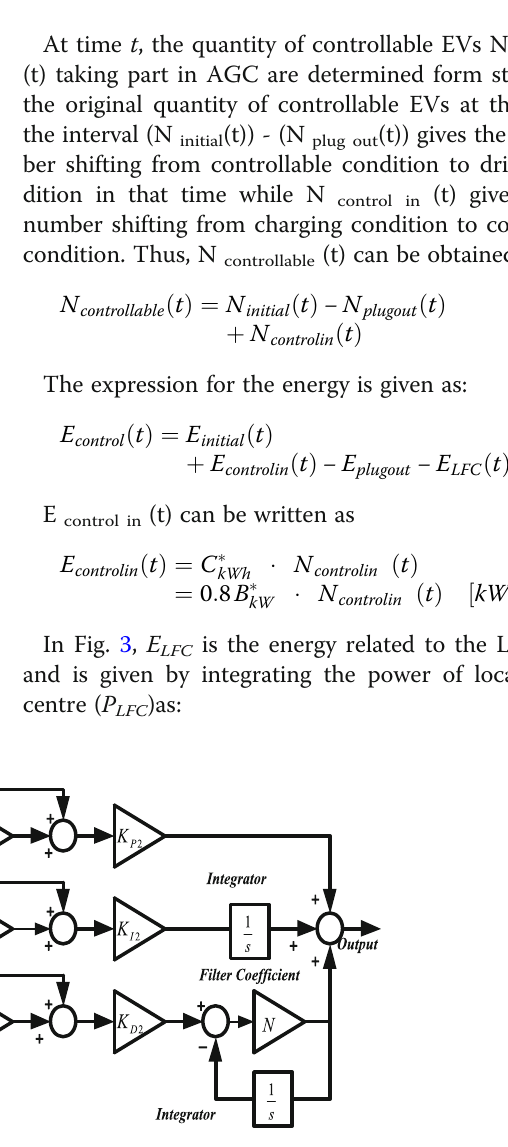
Fig. 4 Adaptive Fuzzy PID structure